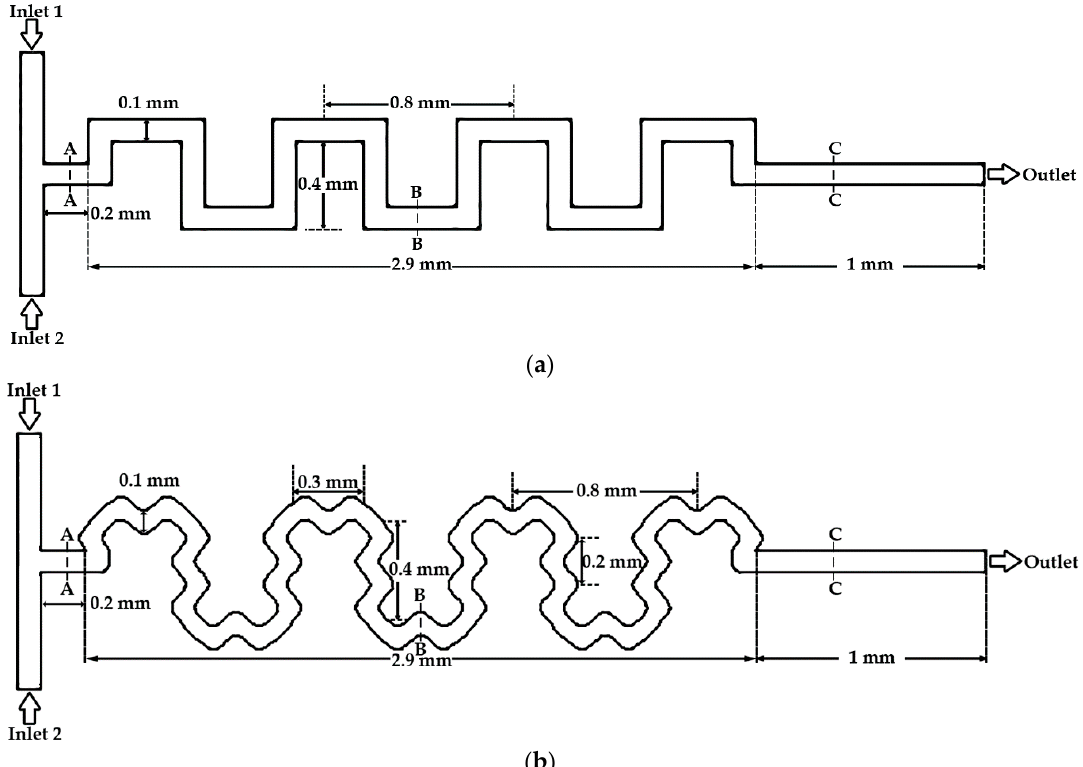
Figure 1. Schematics of microchannels. ( a ) Simple serpentine channel and ( b ) serpentine channel with sinusoidal walls.